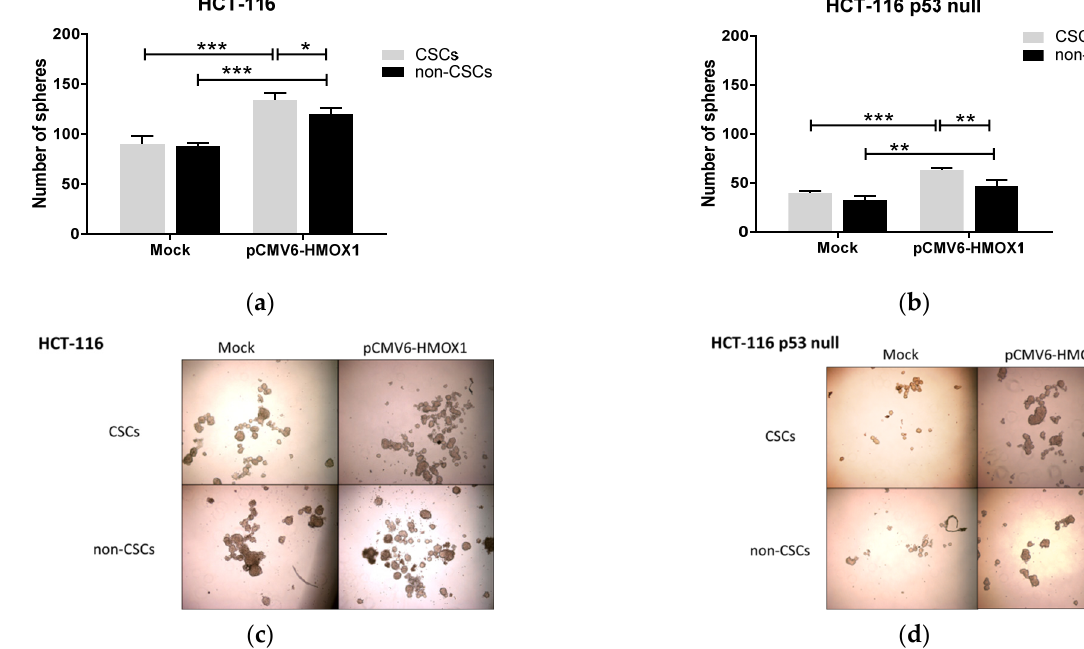
Figure 2. HO-1 overexpression increases self-renewal ability of isolated CRCssubpopulations in cultured cells, regardless of p53 status. The number of spheres formed by subpopulations obtained from mock and pCMV6- HMOX1 ( a ) HCT-116 and ( b ) HCT-116 p53 null transiently transfected cells. Representative images of tumorospheres formed from different subpopulations of pCMV6- HMOX1 ( c ) HCT-116 and ( d ) HCT-116 p53 null transiently transfected cells. TP: total population; CSCs: cancer stem cells subpopulation; non-CSCs: non-cancer stem cells subpopulation. *, p < 0.05; **, p < 0.01; ***, p < 0.001.